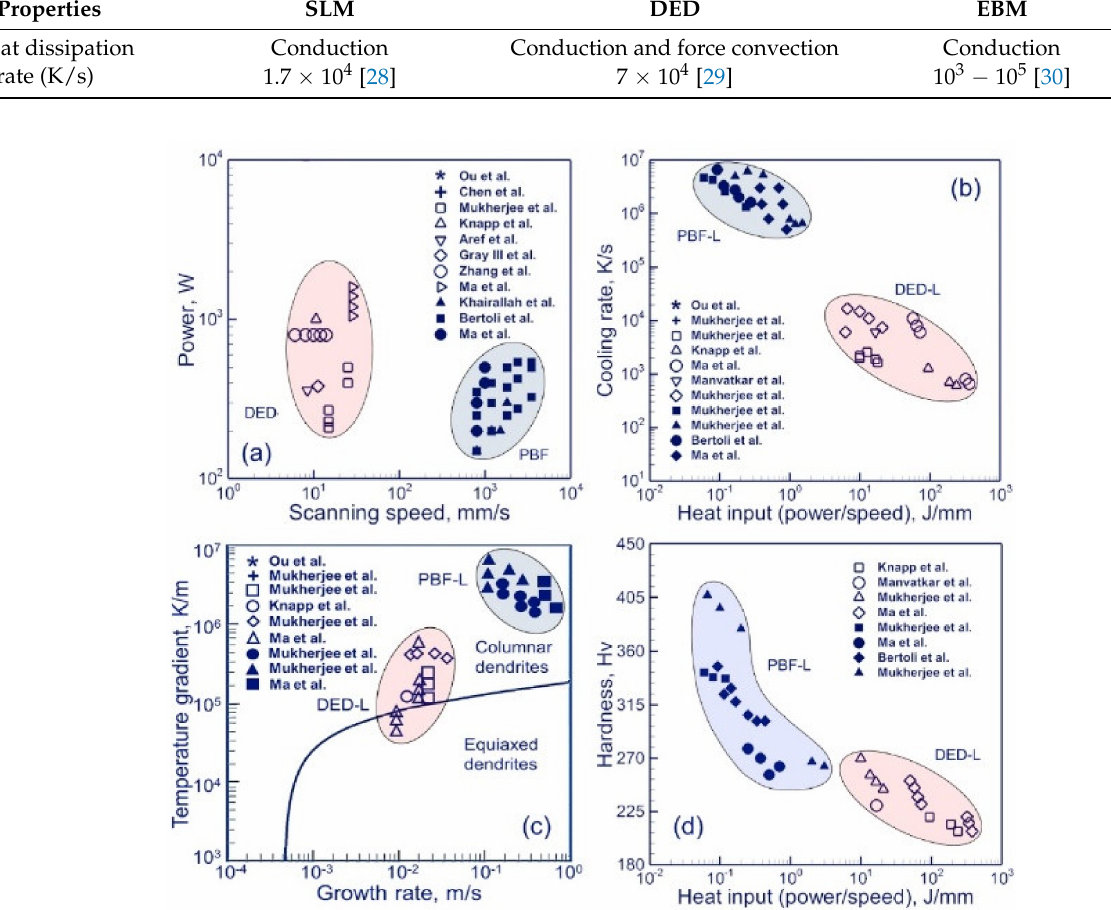
Figure 4. Comparison of SLM and DED: ( a ) power versus scan speed, ( b ) cooling rate versus heat input, ( c ) temperature gradient versus growth rate, and ( d ) hardness versus heat input